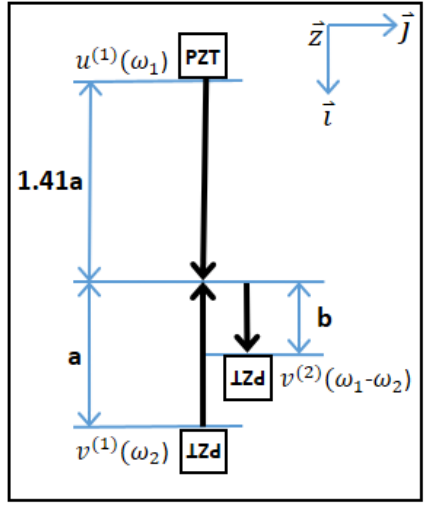
Figure 5. Dispersion curve showing primary and mixing waves: ( a ) Phase velocity; ( b ) Group velocity.